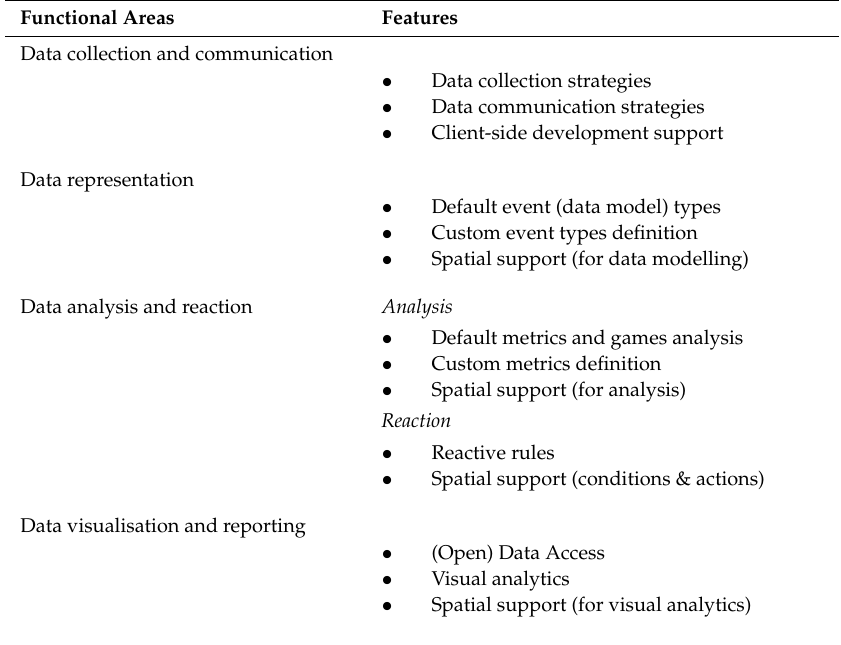
Table 2. Functional areas and contained features for game